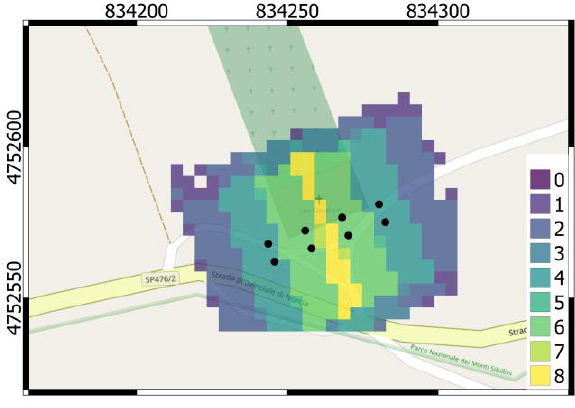
Figure 10. Occurrence map for San Salvatore Church.